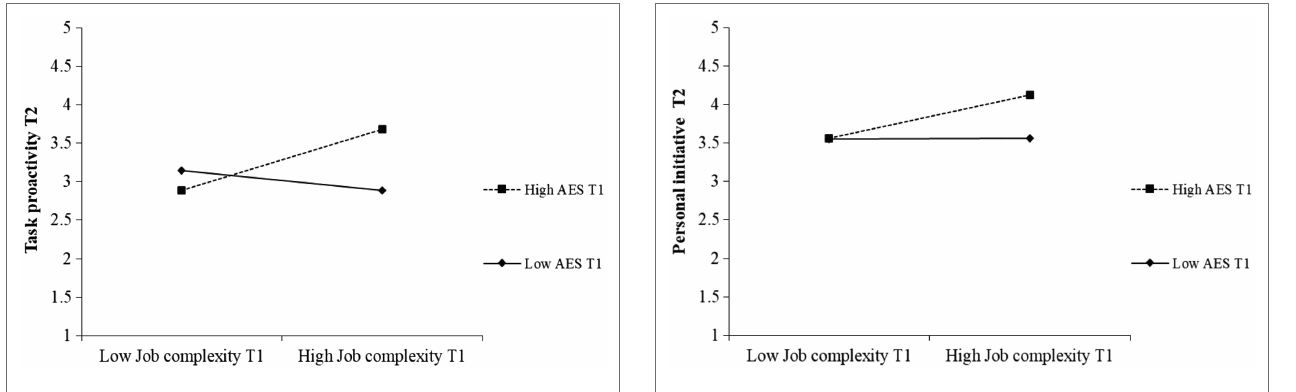
FIGURE 3 | The moderating effect of AES on the relationship between job complexity T1 and employee personal initiative T2 (Study 2).